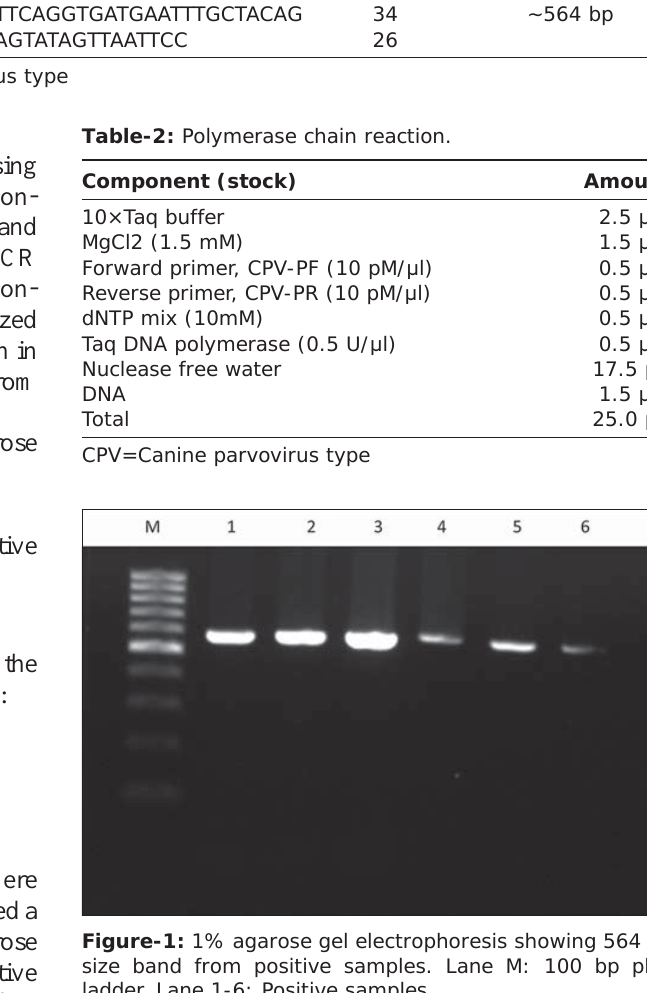
Table-1: Primers used for amplification of tVP2 gene. Target gene